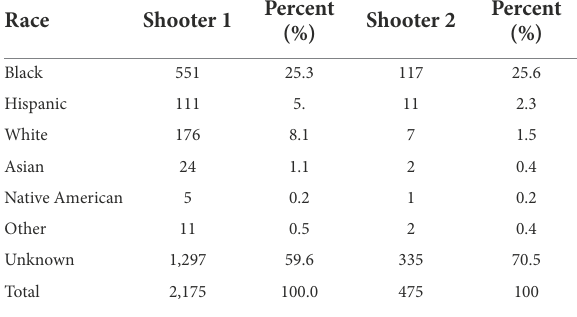
TABLE 2 Race of mass shooters in overall